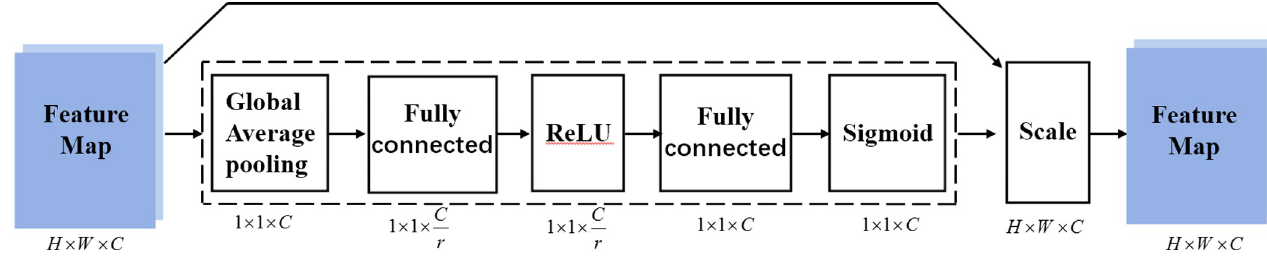
Fig 5. The SENet architecture.